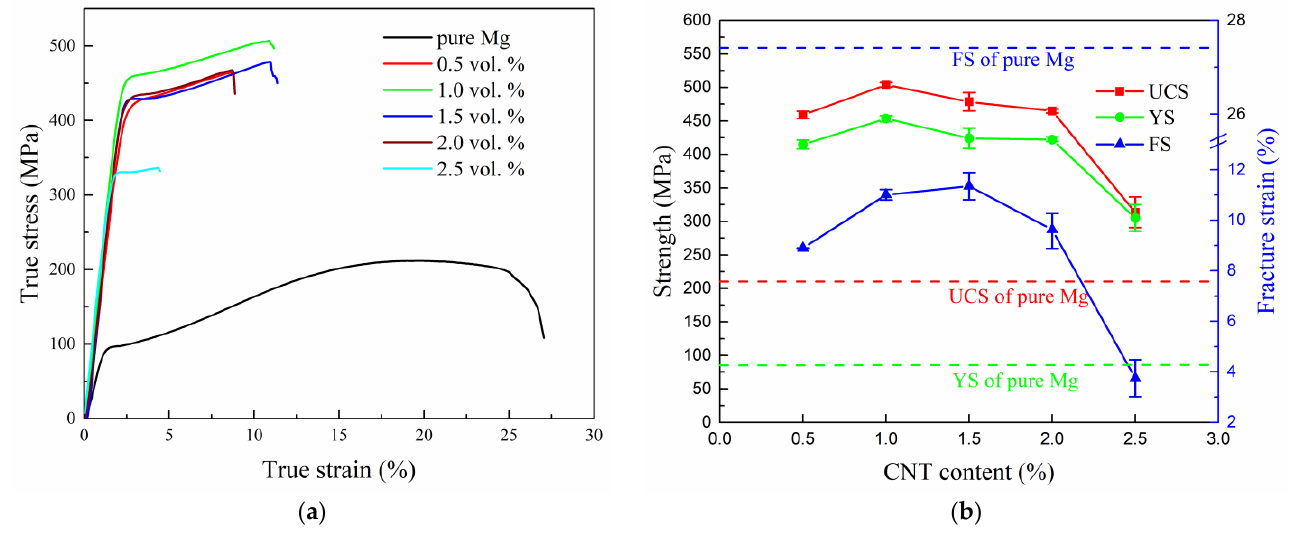
Figure 7. Effects of the CNT content on the compressive properties of CNT/Mg composites: ( a ) typical true stress–strain curve; ( b ) strength and fracture strain. The abbreviations of UCS, YS, and FS represent the ultimate compressive strength, yield strength, and fracture strain, respectively.